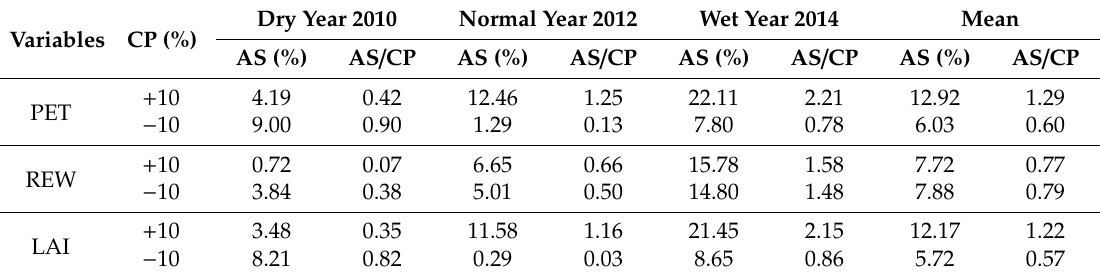
Table 4. The relative sensitivity coe ffi cients of T to PET, REW, and LAI in di ff erent years. Variables CP